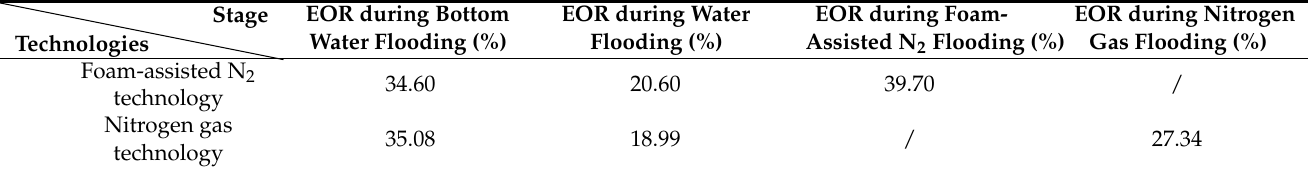
Table 5. Summary of EOR at different stages with different